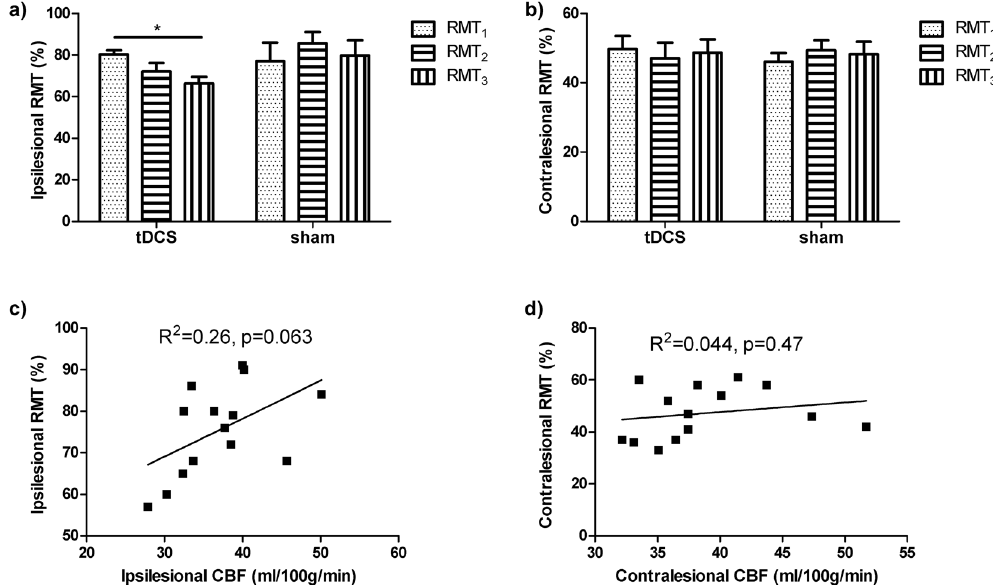
Figure 6. Training effects on RMT and its relationship with CBF. ( a ) Ipsilesional and ( b ) contralesional RMT before (RMT1) and after (RMT2 and RMT3) training. Ipsilesional RMT were decreased in the tDCS, while no change in the contralesional side, nor in the sham group ( * p < 0.05, error bar represents SEM). CBF of the primary motor cortex in all the patients with measurable RMT shows trend of correlation with RMT in the ( c ) ipsilesional but not ( d ) contralesional